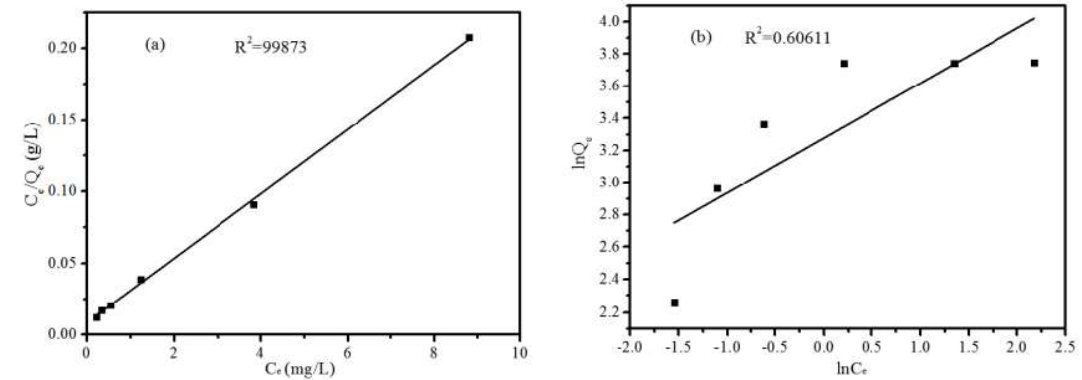
Figure 11. The linearized of Langmuir adsorption isotherm ( a ) and Freundlich adsorption isotherm ( b ) for MB adsorption by B2-CN.